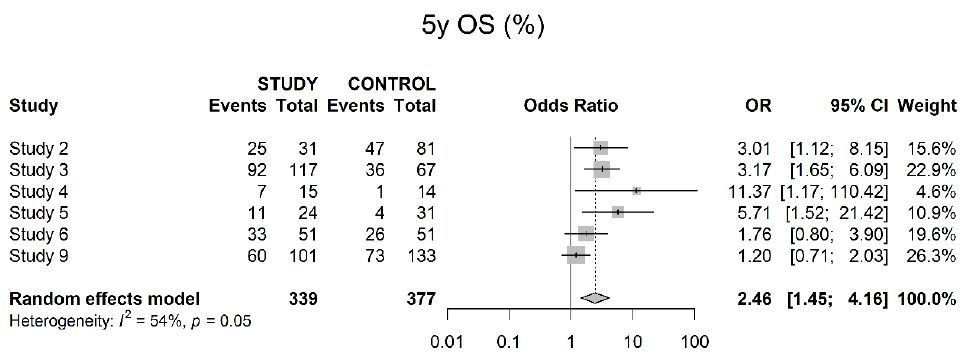
Figure 13. Five-year disease-specific survival. Three studies reported on five-year PFS with a positive trend in favor of neoadjuvant therapy, but without reaching significance (OR 1.78; 95% CI 0.92; 3.44) (Figure 14) . Figure 14. Five-year progression-free survival. Two studies reported PFS data adjusted for multivariate analysis (Intuition for In- verse Probability of Treatment Weighting (IPTW) adjusted PFS). Meta-analysis showed a significant risk reduction in disease progression in patients treated with NAC (HR 0.42; 95% CI 0.19; 0.91) (Figure 15) .